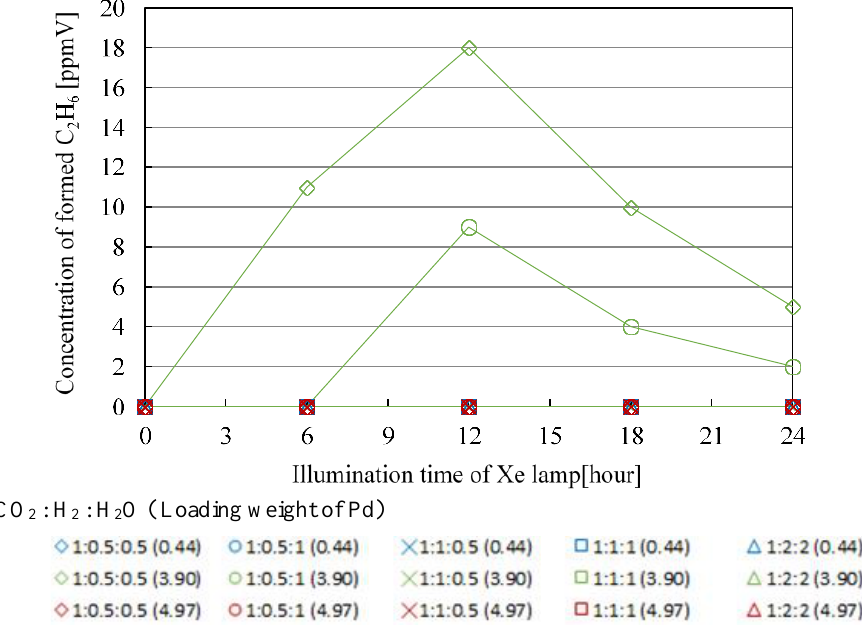
Figure 10. Change in concentration of formed C 2 H 6 with the illumination time among different molar ratios of CO 2 /H 2 /H 2 O and Pd loading weight with UV light illumination. Table 1. Comparison of maximum concentration of formed CO with illumination time among different molar ratios of CO 2 /H 2 /H 2 O and Pd loading weight with UV light illumination.